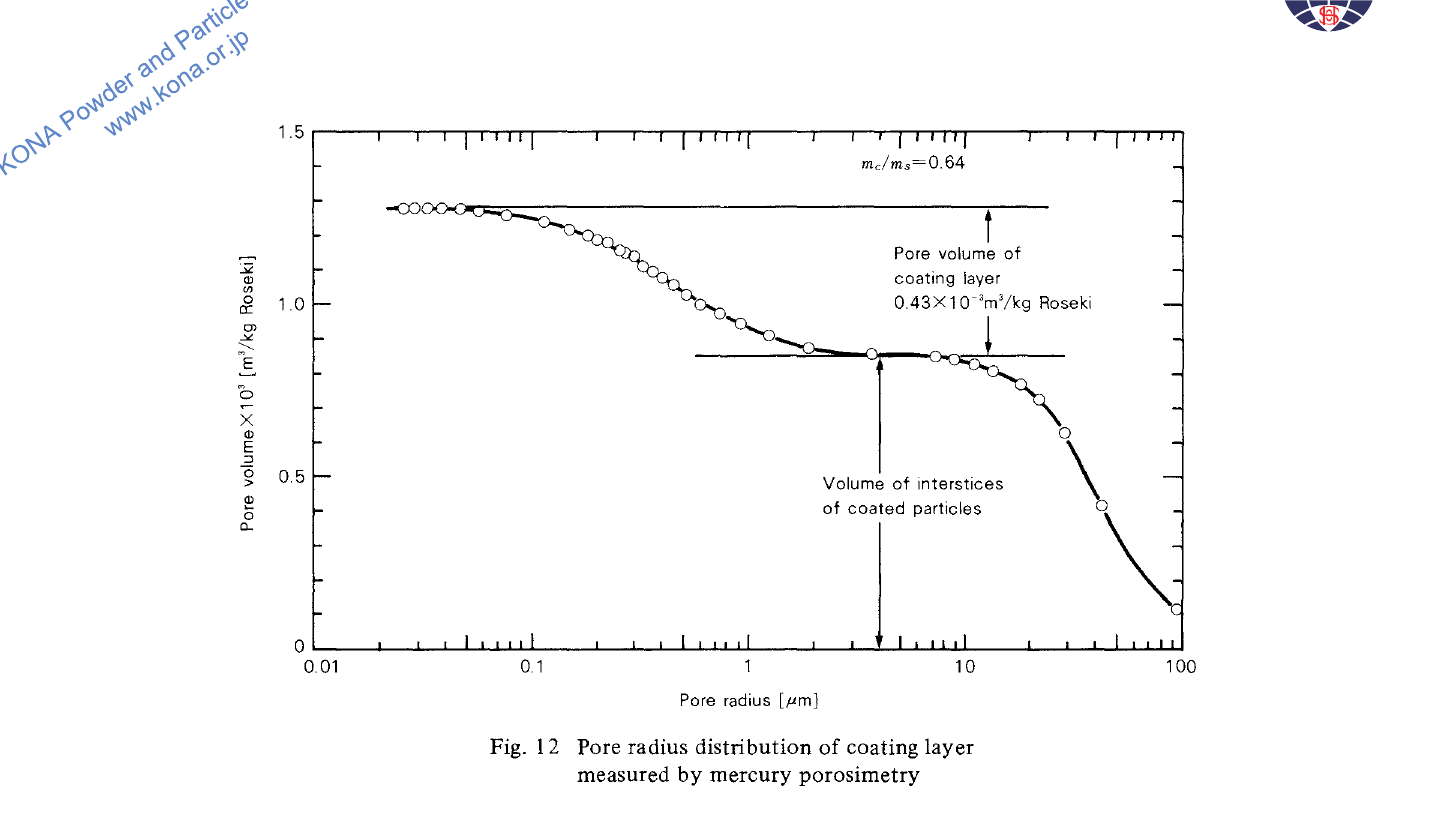
Fig. 12 Pore radius distribution of coating layer measured by mercury